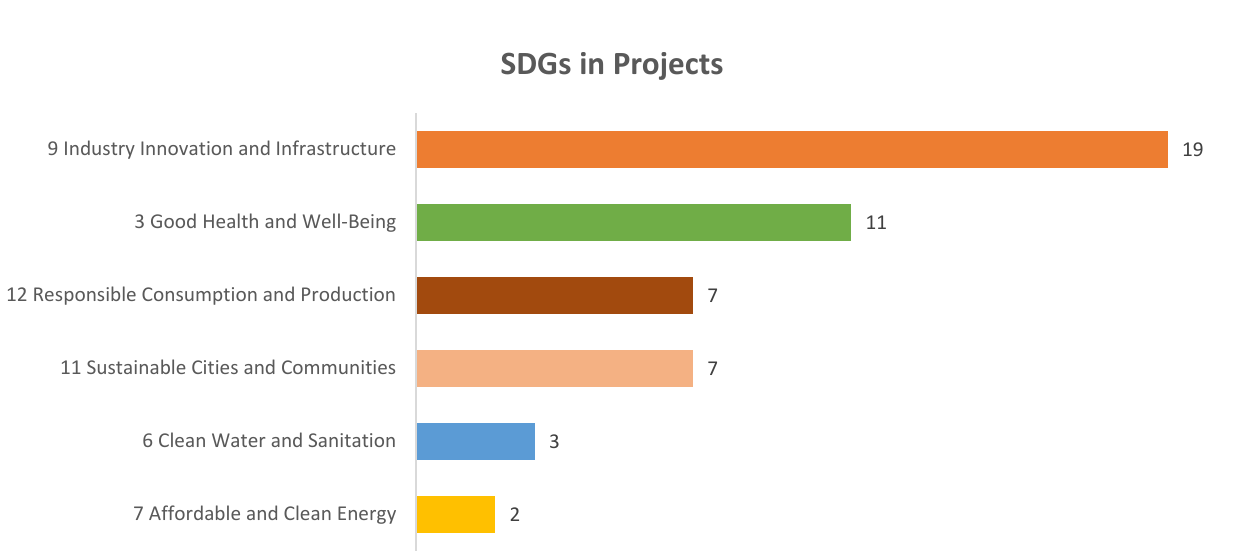
Figure 1. Sustainable Development Goals in projects. Source: own study.